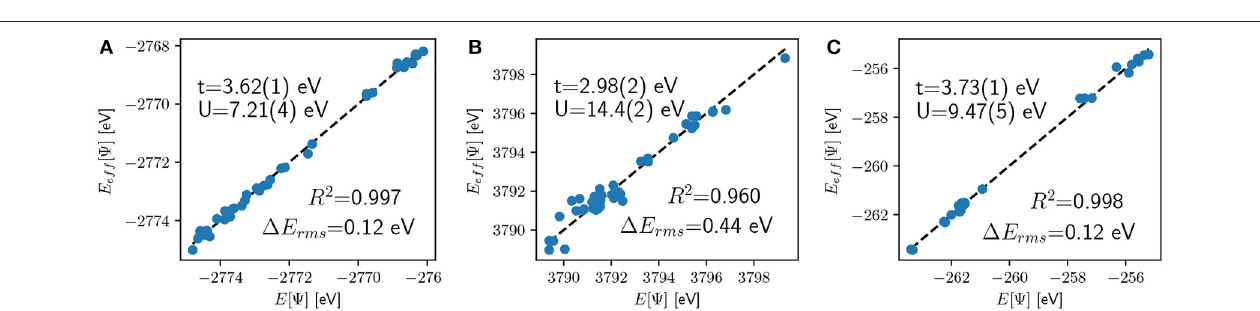
3 periodic unit cell of graphene and hydrogen lattice: (A) graphene; (B) π -only ×